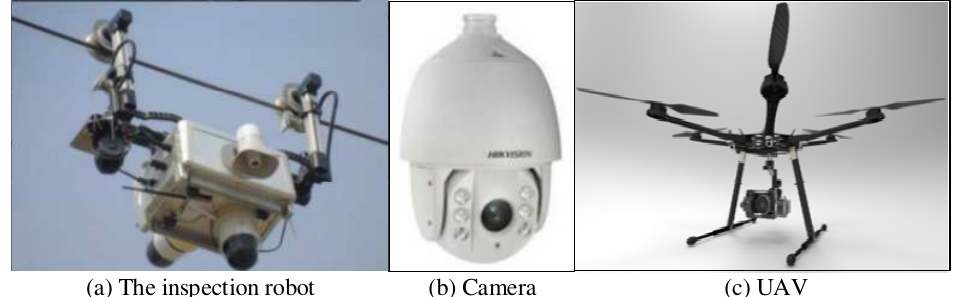
Figure 2. Hardware acquisition device for on-line monitoring system of transmission line connec- tion fittings. ( a ) The inspection robot. ( b ) Camera. ( c ) UAV.